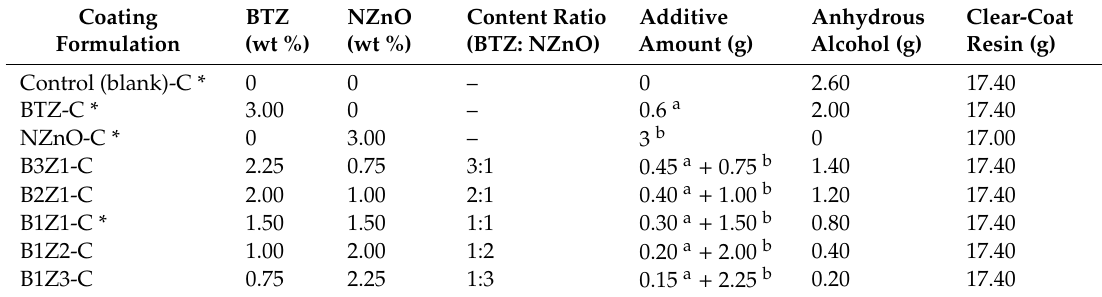
Table 1. Coating formulations used in this